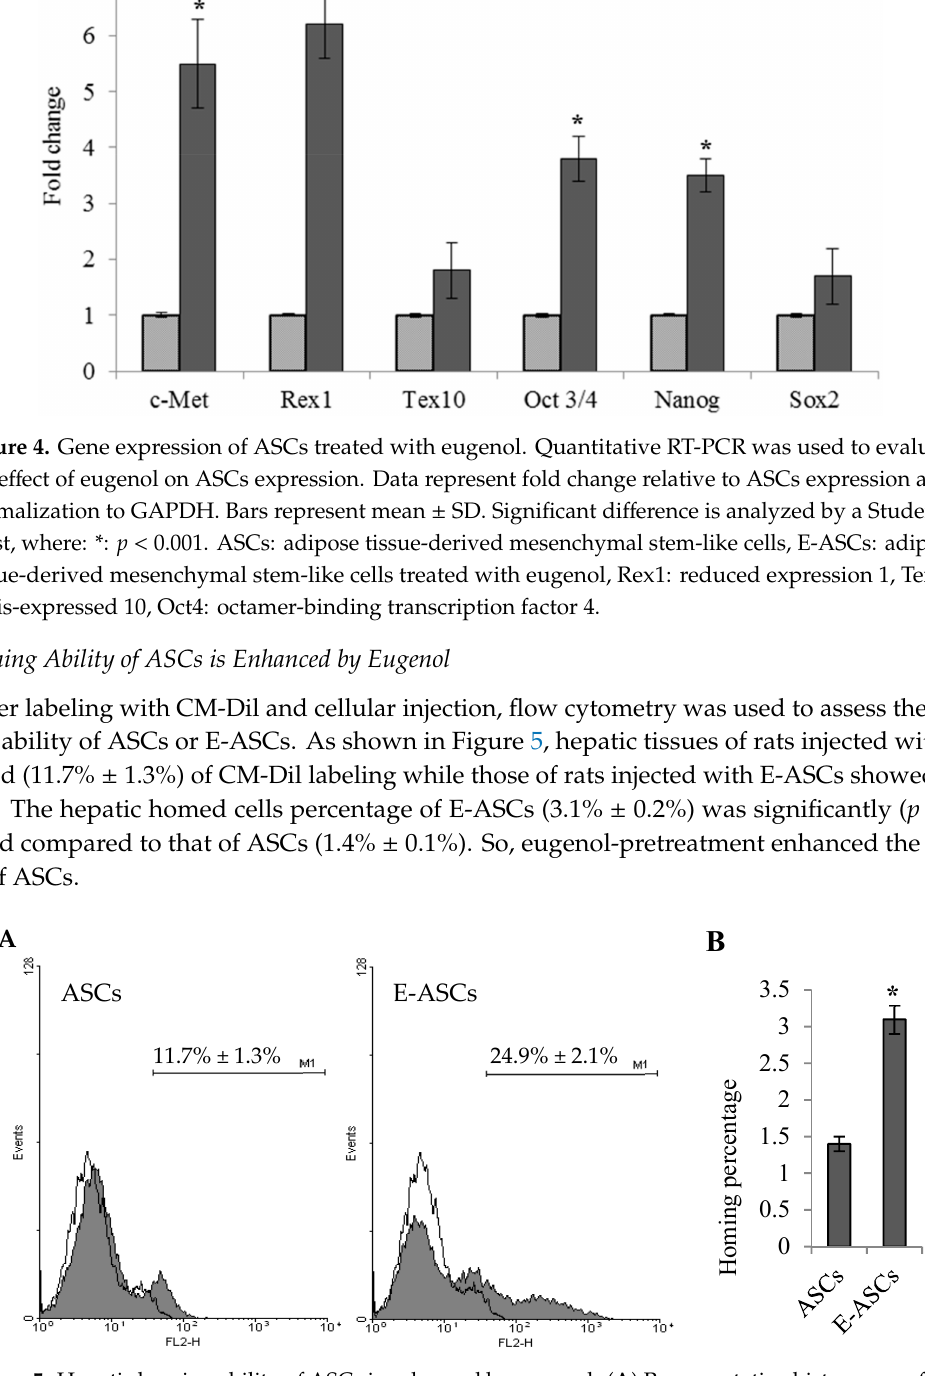
Figure 5. Hepatic homing ability of ASCs is enhanced by eugenol. ( A ) Representative histograms of the flow cytometric analysis for hepatic tissues of rats injected with CM-Dil-labeled ASCs or CM-Dil-labeled E-ASCs. ( B ) The percentage of homing. Bars represent mean ± SD. Significant di ff erence is analyzed by a Student’s t -test, where: *: p < 0.001. ASCs: adipose tissue-derived mesenchymal stem-like cells, E-ASCs: adipose tissue-derived mesenchymal stem-like cells preconditioned with eugenol.